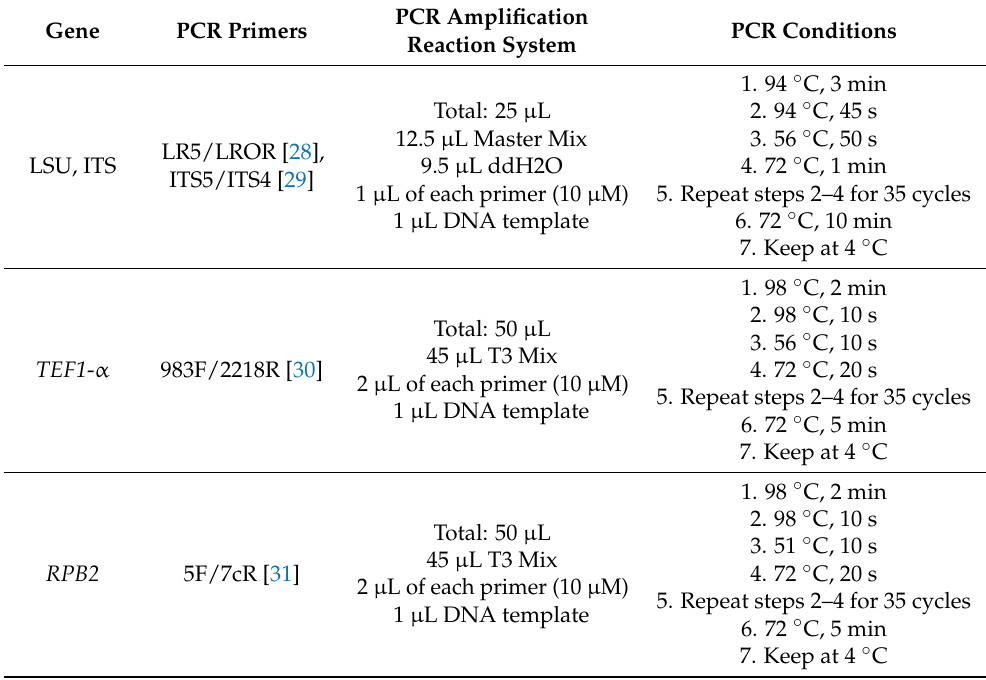
Table 1. The primers for the LSU, ITS, TEF1 - α and RPB2 genes and the PCR thermal cycle programs used in this